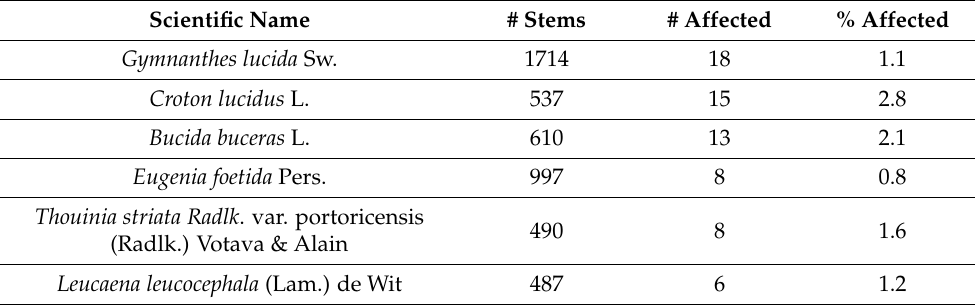
Table 2. The affected species (encountering lost or/and damaged stem), number of stems, number of affected, and proportion of affected in the 15 plots at NEON Gu á nica dry forest